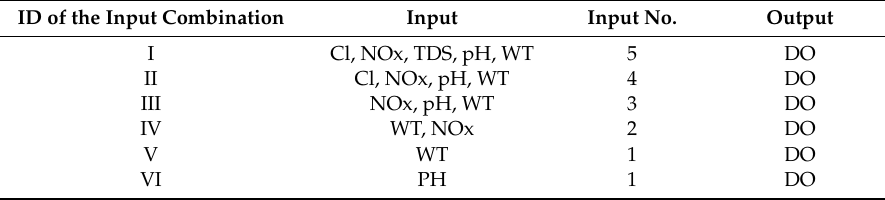
Table 2. Input combinations for structuring the MLP and CCNN models.